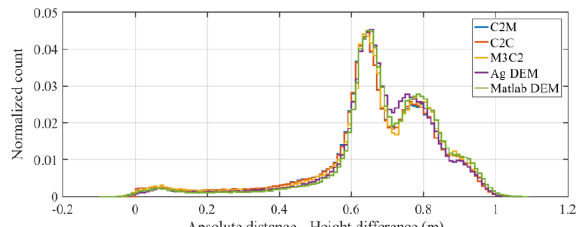
Figure 7. Crop height of test area calculated from different